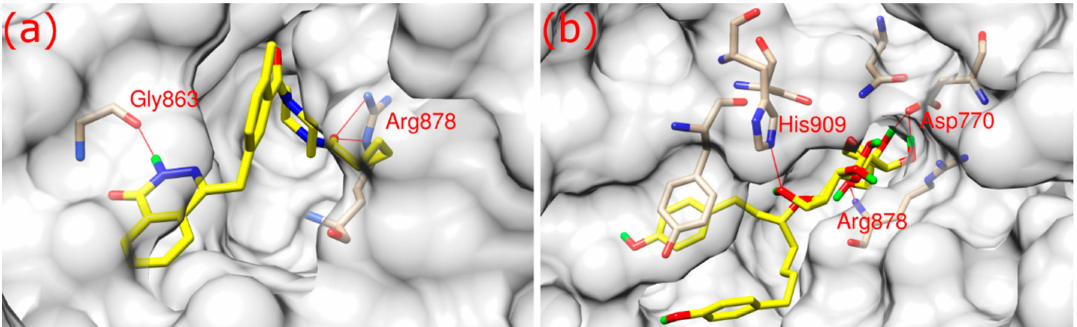
Figure 2. Binding modes of inhibitors towards PARP1 at the binding site. ( a ) Binding mode of olaparib; ( b ) binding mode of ZINC67913374. The surface of PARP1 is presented as gray with 70% transparency. Inhibitors are shown as yellow stick. Corresponding residues of PRAP1 forming hydrogen bonds with ligands are displayed as tan stick. Color code for elements: tan—C of PARP1; yellow—C of inhibitor; blue—N; red—O;